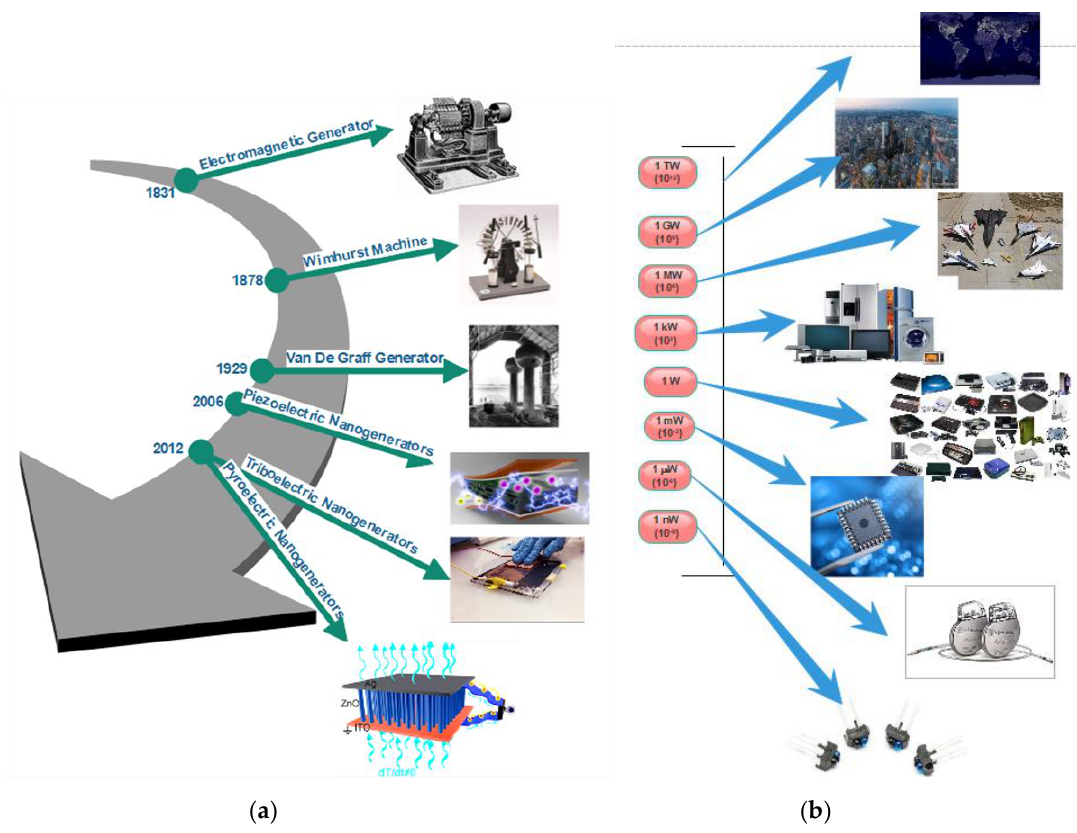
Figure 1. ( a ) The major inventions in the history of mechanical energy-harvesting technology. ( b ) Energy required for various devices at various power scales. Nanomaterials 2019 , 8 , x FOR PEER REVIEW